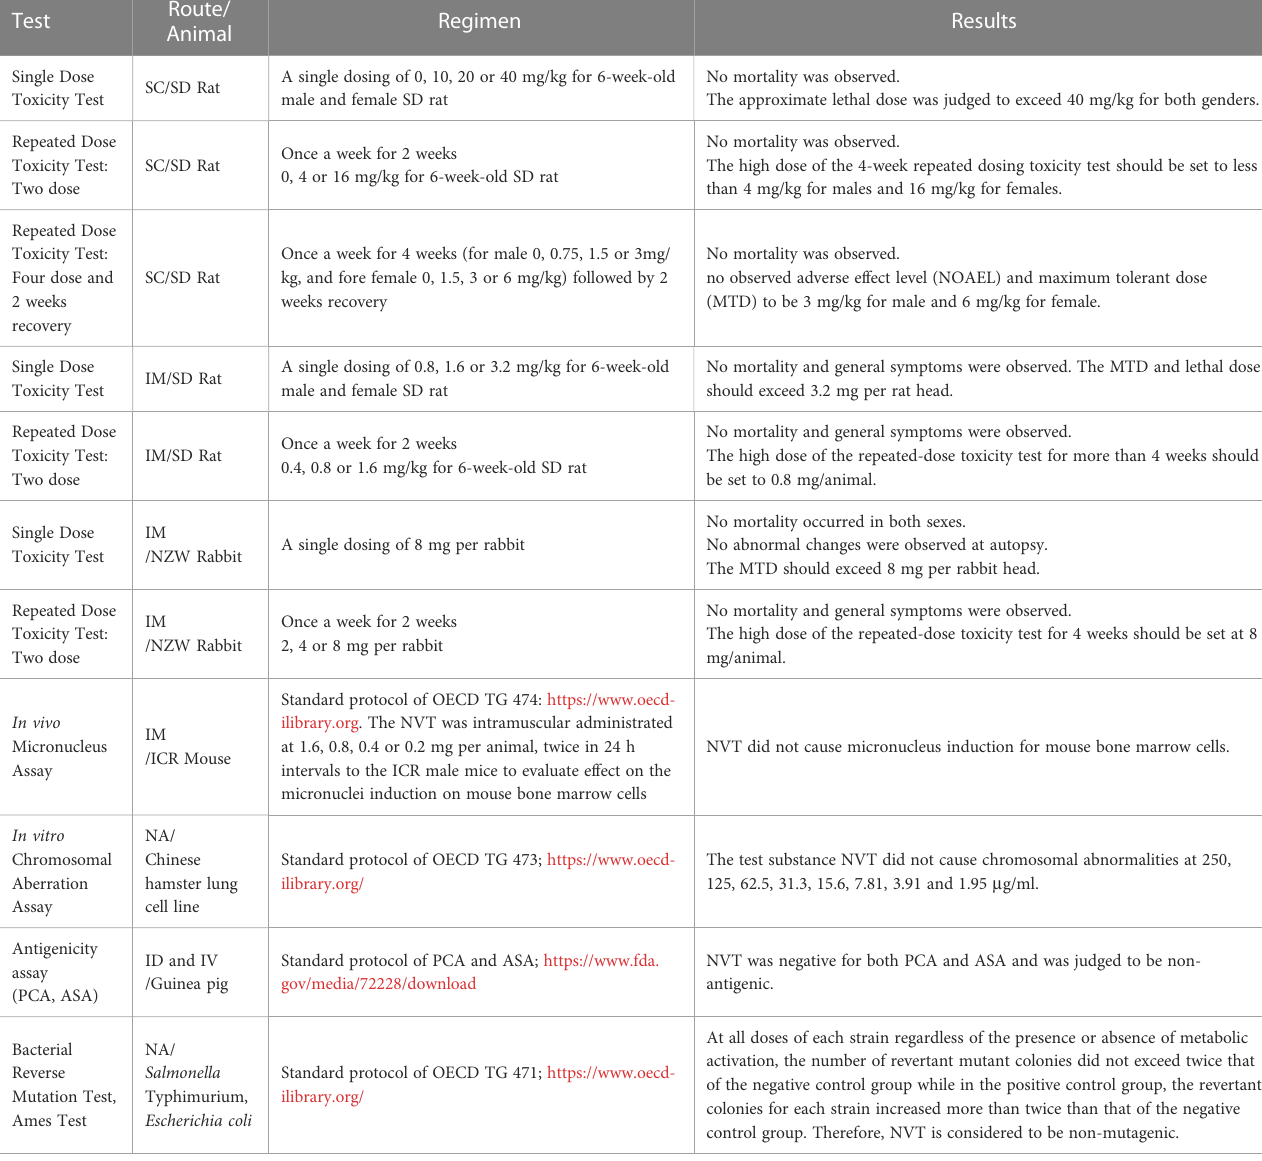
TABLE 1 Summary of GLP toxicity study results for NVT.